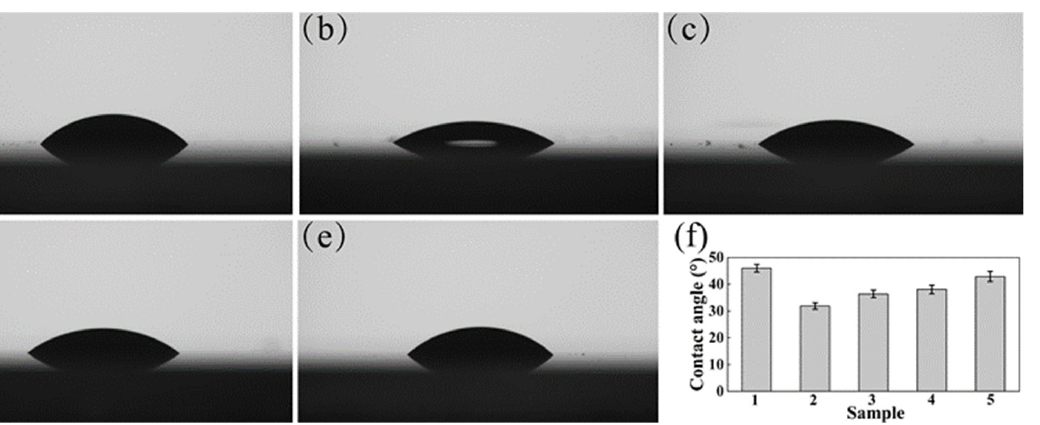
Figure 5. Contact angle analysis of WPU and WPUA emulsion. ( a – e ) Contact angle images of WPU, WPUA-10, WPUA-20, WPUA-30, and WPUA-40. ( f ) Schematic diagram illustrating the contact angles of WPU and WPUA emulsions. The numbers 1, 2, 3, 4, and 5 inserted in f represent WPU, WPUA-10, WPUA-20, WPUA-30, and WPUA-40, respectively.